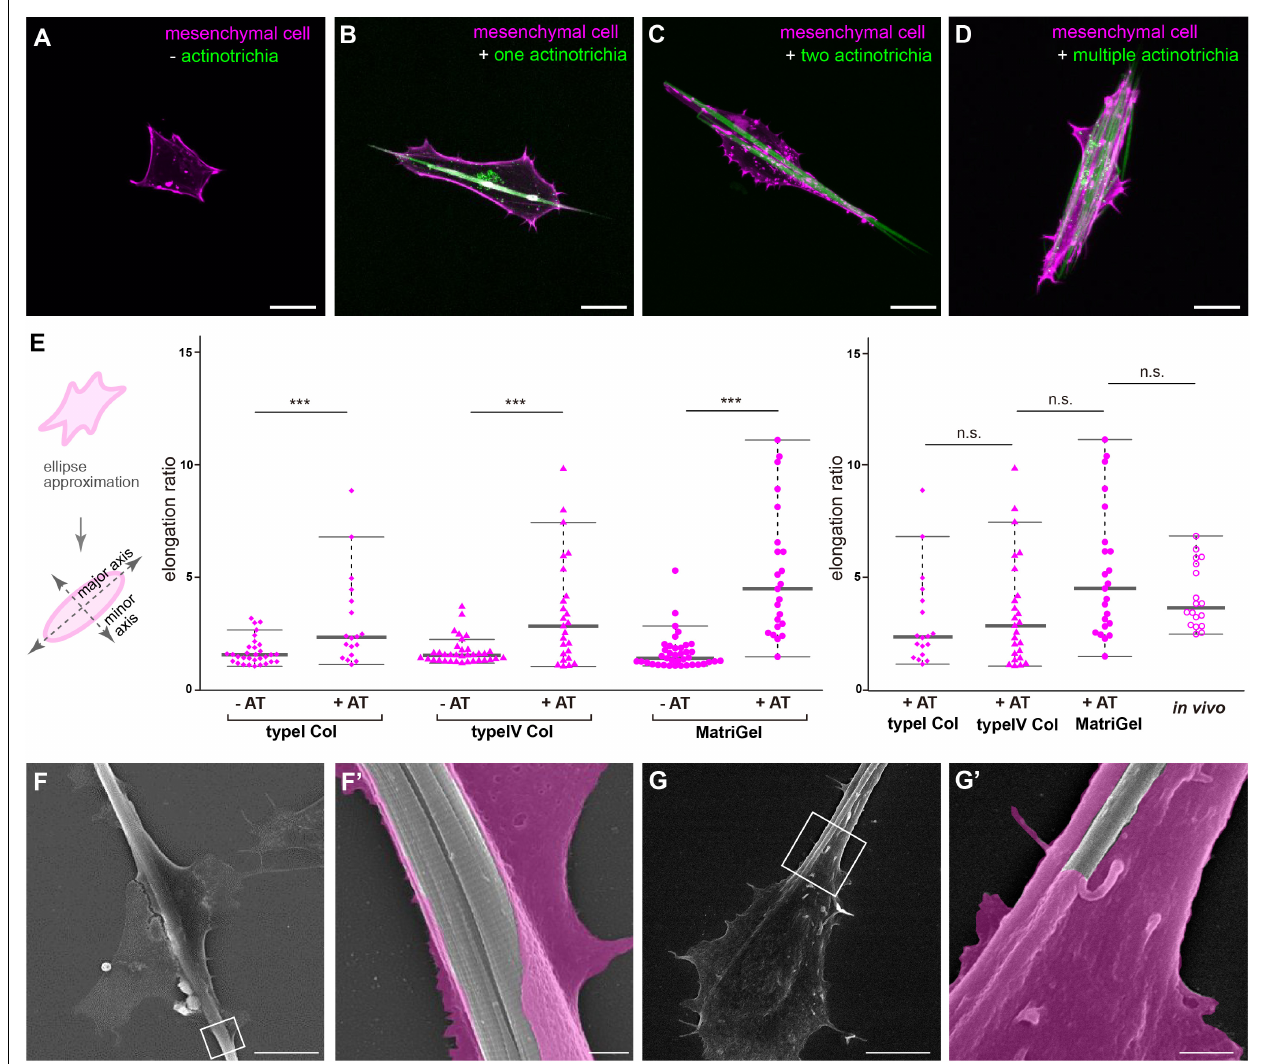
FIGURE 3 | Interaction between mesenchymal cells and actinotrichia in vitro. (A–D) The morphology of primary cultured mesenchymal cells at day 2 after culture on a Matrigel-coated dish. Mesenchymal cells and actinotrichia were isolated from TG larval fins [TG; 5 x and1 (MC]: Lifeact-mCherry/5 x and1 (2P): And1 full -GFP). (A) In the condition without actinotrichia, mesenchymal cells showed the symmetric morphology. (B–D) In the condition with actinotrichia, mesenchymal cells elongated along a single actinotrichia (B) , two actinotrichia (C) and multiple actinotrichia (D) . (E) Cell aspect ratio of mesenchymal cells. Mesenchymal cells in contact with actinotrichia had a more elongated shape compared to the cells not in contact with actinotrichia. (F–G (cid:48) ) SEM images of cultured mesenchymal cells holding the actinotrichia on a Matrigel-coated dish. The actinotrichia was surrounded with the plasma membrane of the mesenchymal cell (F) and partially embedded inside the mesenchymal cell (G) . The magnified images in white box are shown. P -values: *** P < 0.0001. AT, actinotrichia. Scale bars: 20 µ m in (A–D) , 10 µ m in (F,G) , 1 µ m in (F (cid:48) ,G (cid:48) )